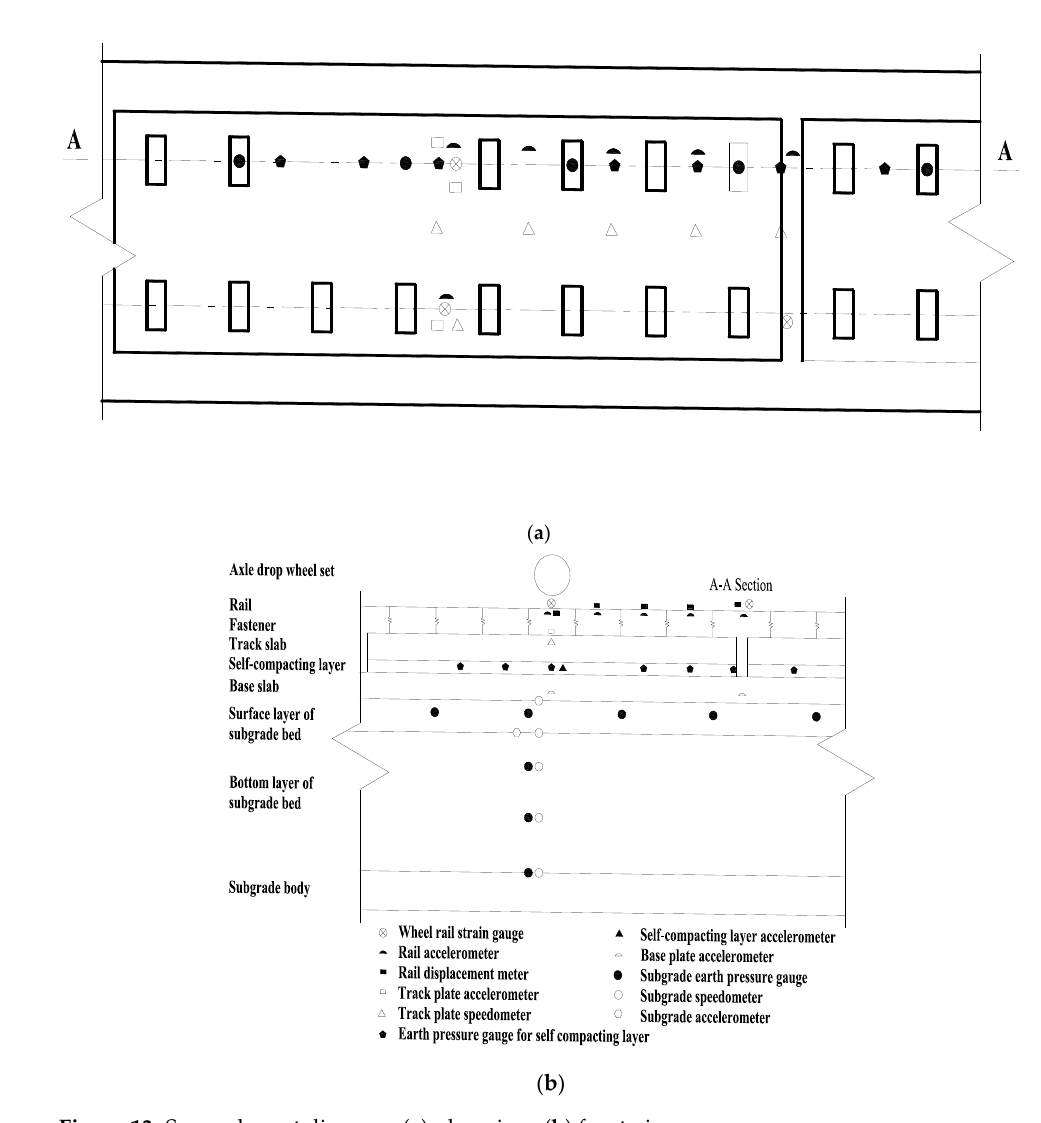
Figure 14. CRTS Ⅲ SBT subgrade full-scale model test platform and axle falling impact device. The dynamic performance of the finite element structure of the CRTS Ⅲ SBT is veri- fied by the falling axle model. The dynamic model inherits the static model and adds a rigid wheelset. The center of mass of the wheelset is taken at the center of the axle, and